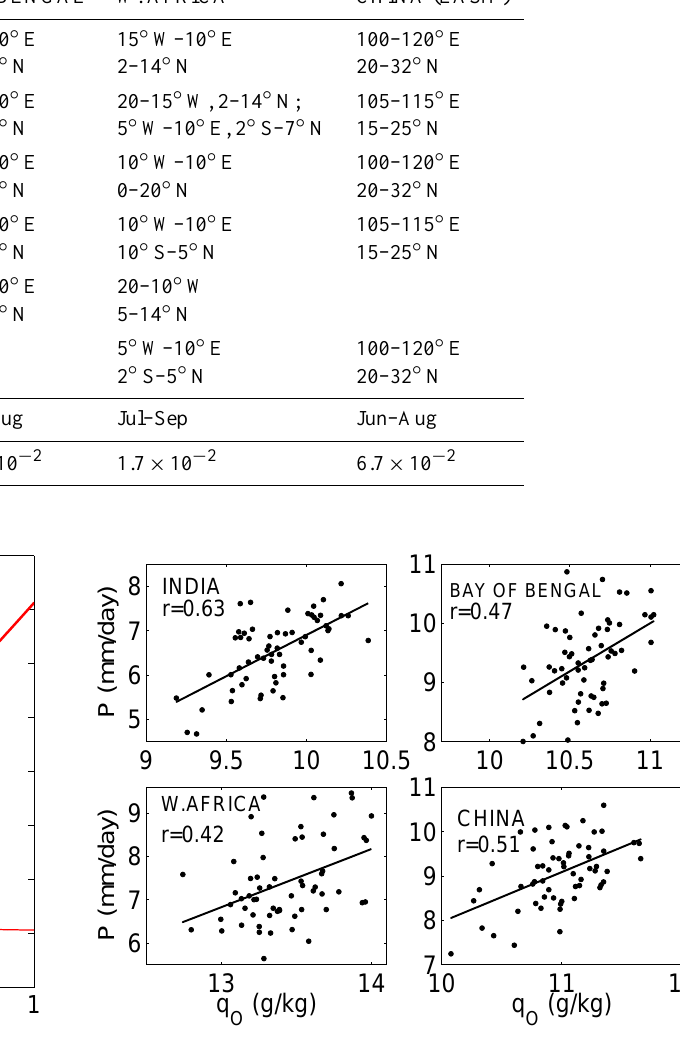
Fig. 8. Correlation between precipitation and specific humidity over the ocean from NCEP/NCAR reanalysis data. Black lines show the result of a linear regression; the correlation coefficients are